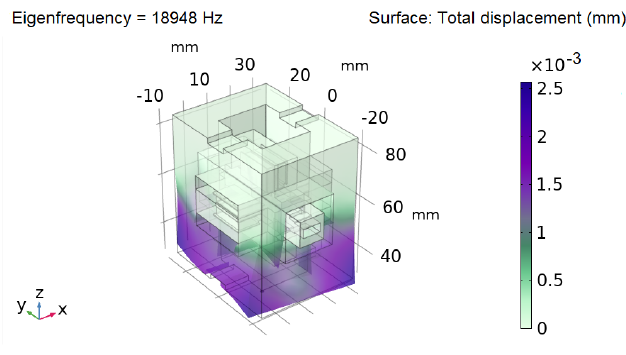
FIGURE 13. Mechanical Deformations at First Eigenfrequency (18 KHz)